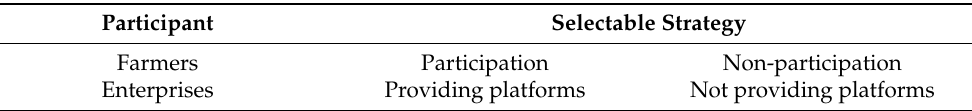
Table 4. Selectable strategies of farmers and